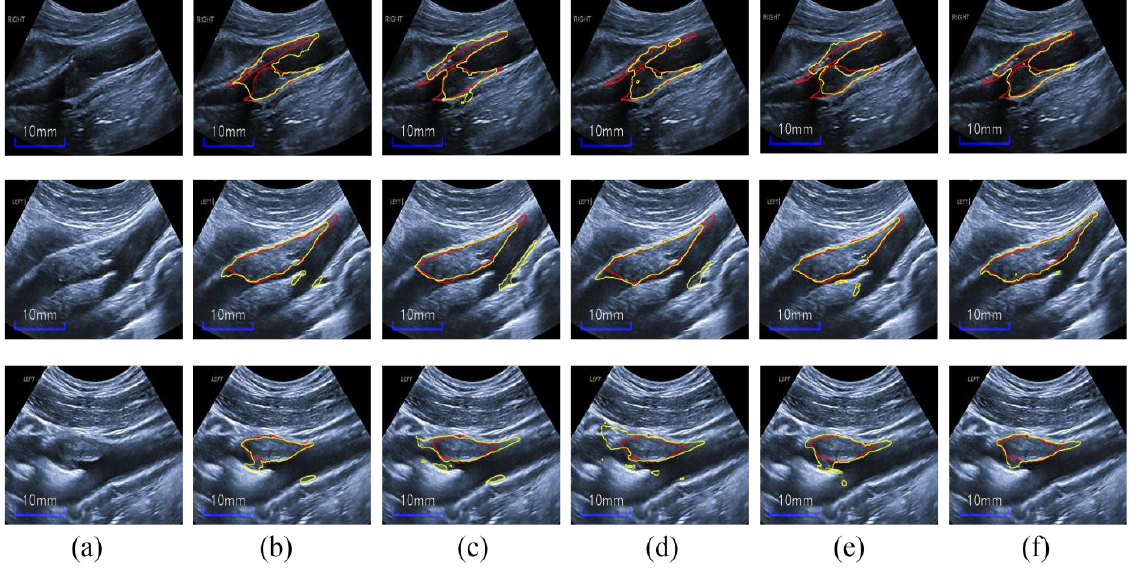
Figure 10. CBV effect: ( a ) input images, ( b ) M-Net, ( c ) U-Net, ( d ) Attention U-Net, ( e ) HRU-T, and ( f ) HRU-CBV-T (proposed). The red and yellow outlines superimposed on the input images denote the labels and segmentation-result contours.